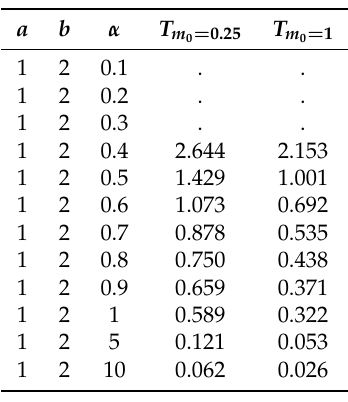
Table 2. Solvability of the ODE (52) with the states a = 1 and b = 2.